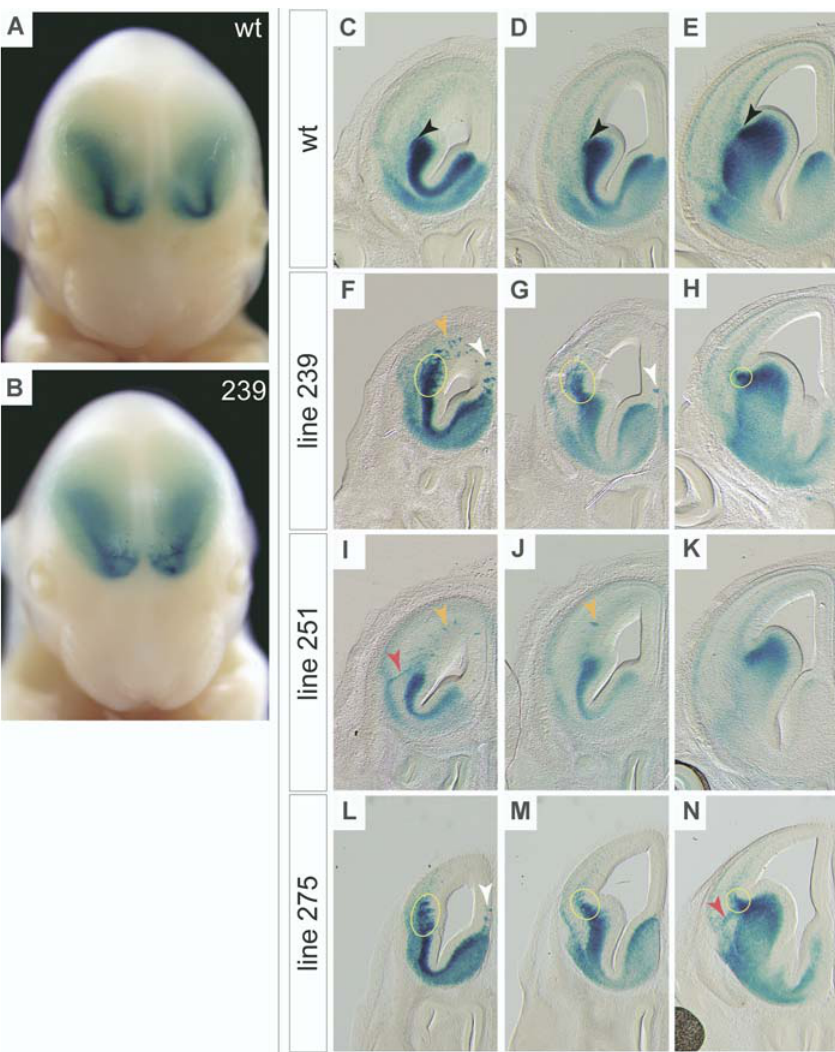
Figure 5. Line 239, 251, and 275 Mutants Have Similar Migration Defects (A) Frontal view of an E14.5 WT embryo. (B) Frontal view of an E14.5 embryo homozygous for the line 239 mutation. The stream of cells leaving the SVZ of the LGE is streaky and aggregated in the rostral cortex of the mutant. (C–E) A rostral-to-caudal series of coro- nal sections from an E14.5 WT embryo. WT embryos have diffuse cortical stain- ing and a sharp boundary (black arrow- heads) between the subcortical and the cortical telencephalon. (F–H) Coronal sections from E14.5 line 239 mutant forebrains. Yellow circles indicate the area of the cortical-subcor- tical boundary where a large excess of migrating cells can be seen in the IZ/SVZ area. Orange arrowhead indicates aggre- gated cells in the IZ/SVZ of the lateral wall of the cortex. White arrowheads indicate aggregates in the medial wall. The staining in the MZ appears normal. Defects become less apparent in the more caudal sections. (I–K) Sections from an E14.5 line 251 mutant embryo. Orange arrowheads in- dicate aggregates in the lateral wall of the cortex. In (I), a linear aggregate of stained cells can be seen extending from the IZ/SVZ to the MZ (red arrowhead). The cortical-subcortical boundary is well defined in line 251 mutants. (L–N) Sections from an E14.5 line 275 mutant embryo. Yellow circles indicate aberrant staining in the cortical-subcor- tical boundary region. The white arrow- head indicates aggregates in the medial wall of the cortex, and the red arrowhead points to a radially directed aggregate of cells extending from the IZ/SVZ to the MZ. DOI: